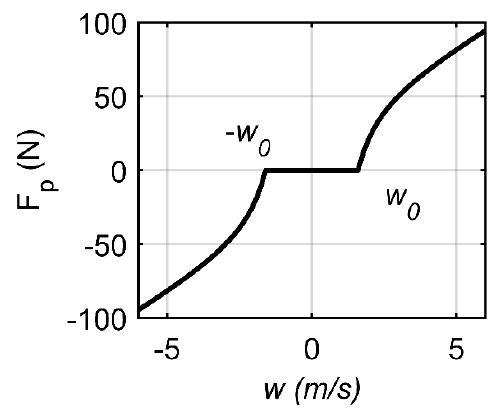
Figure 2. Non-linear planing force.